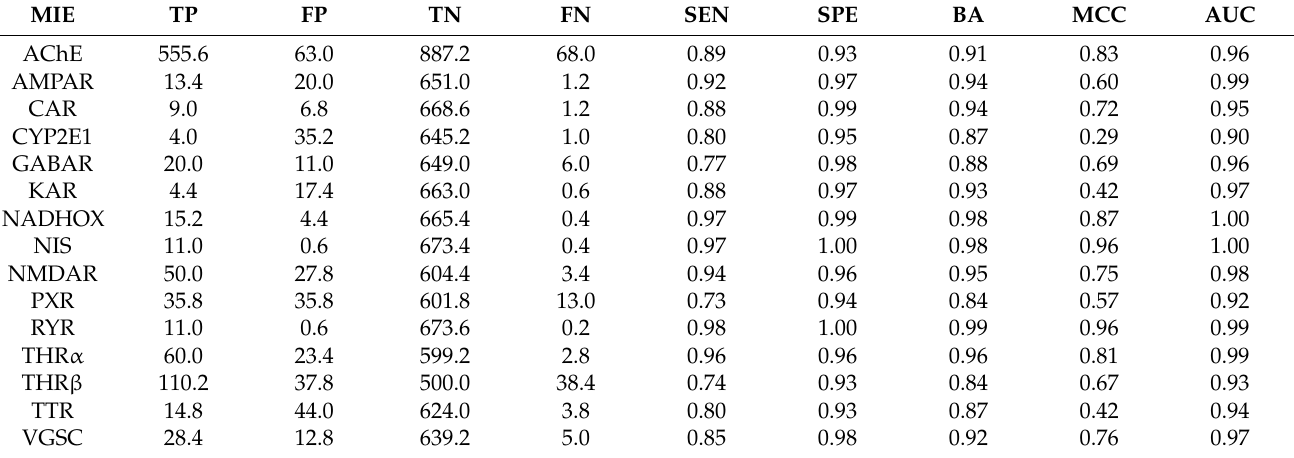
Table 1. External validation of QSAR models for MIEs based on ChEMBL data. For each MIE predicting QSAR the average number of true positives (TP), false positives (FP), true negatives (TN), and false negatives (FN) were reported. The metrics for evaluating the predictivity of the models were sensitivity (SEN), specificity (SPE), balanced accuracy (BA), Matthew’s correlation coefficient (MCC) and area under the ROC curve (AUC). Performance is the average of metrics obtained over 100 different training-test splits.